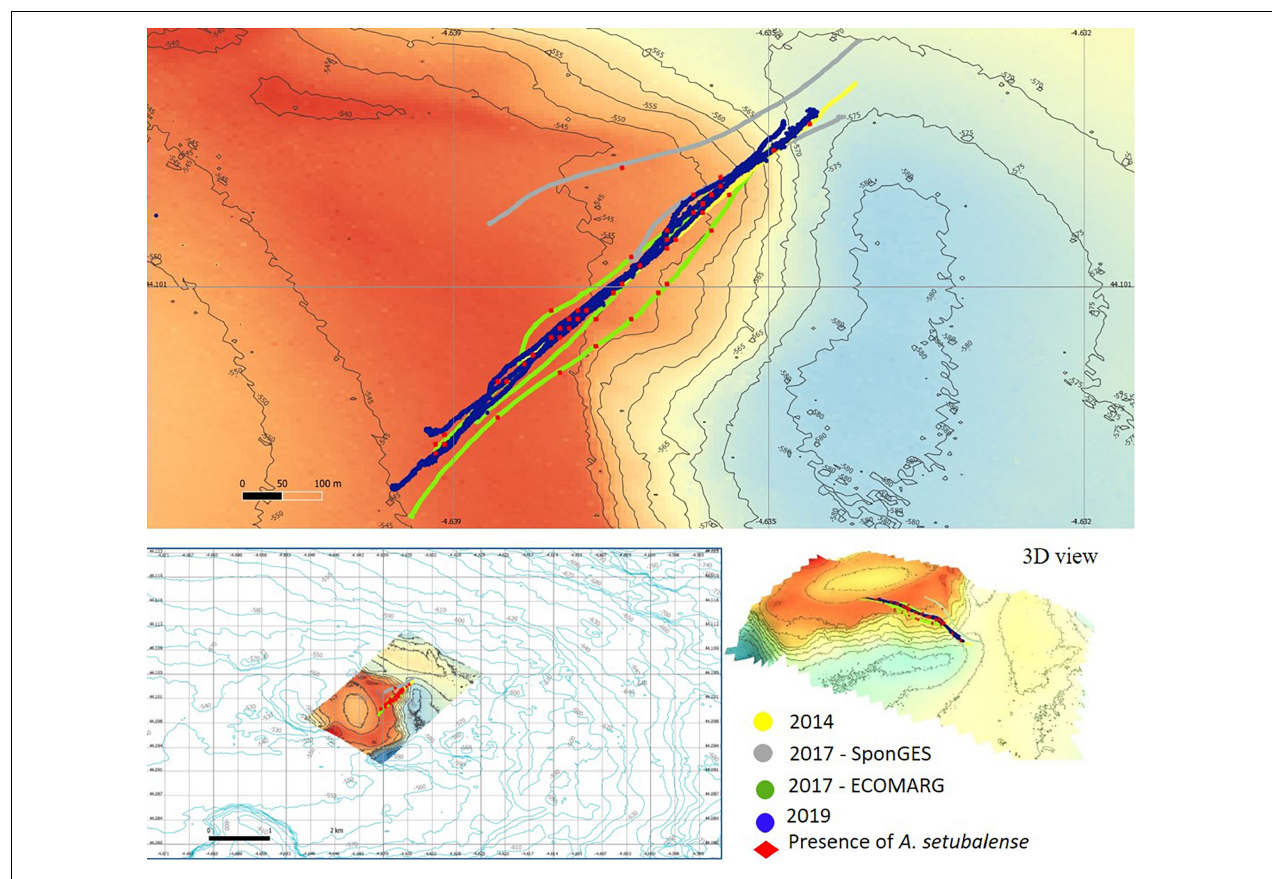
FIGURE 3 | Study zone 2: bathymetric characteristics, temporal image sampling series and presence of A. setubalense